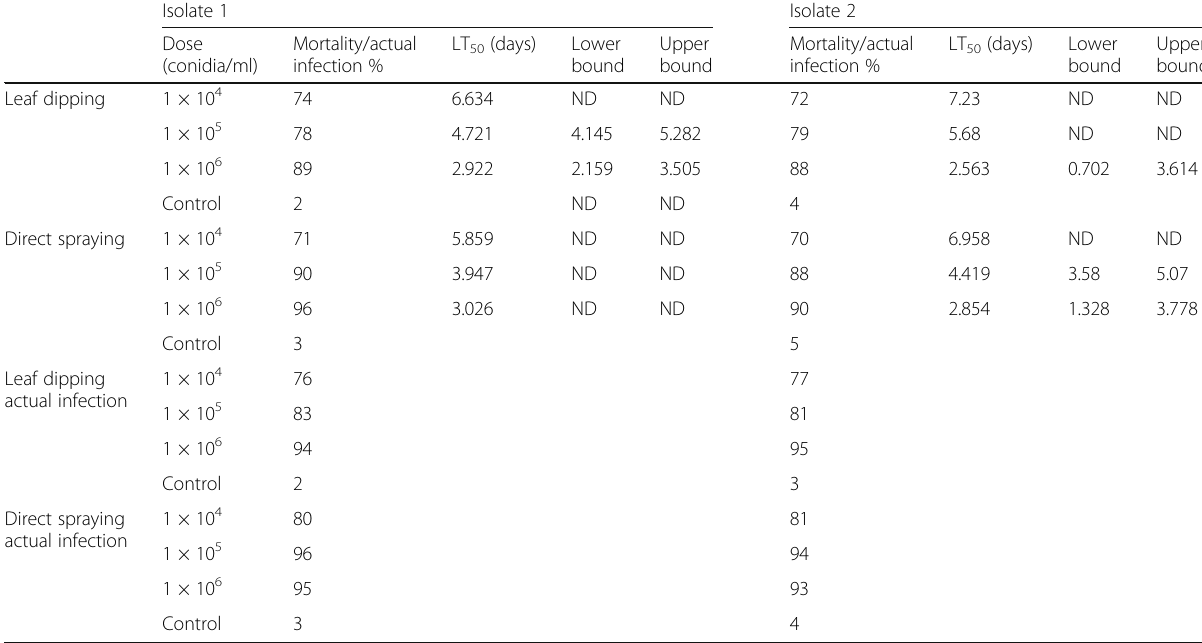
Table 2 Leaf dipping and direct spraying LT 50 values against Orosanga japonica nymphs Isolate 1 Isolate 2 Dose